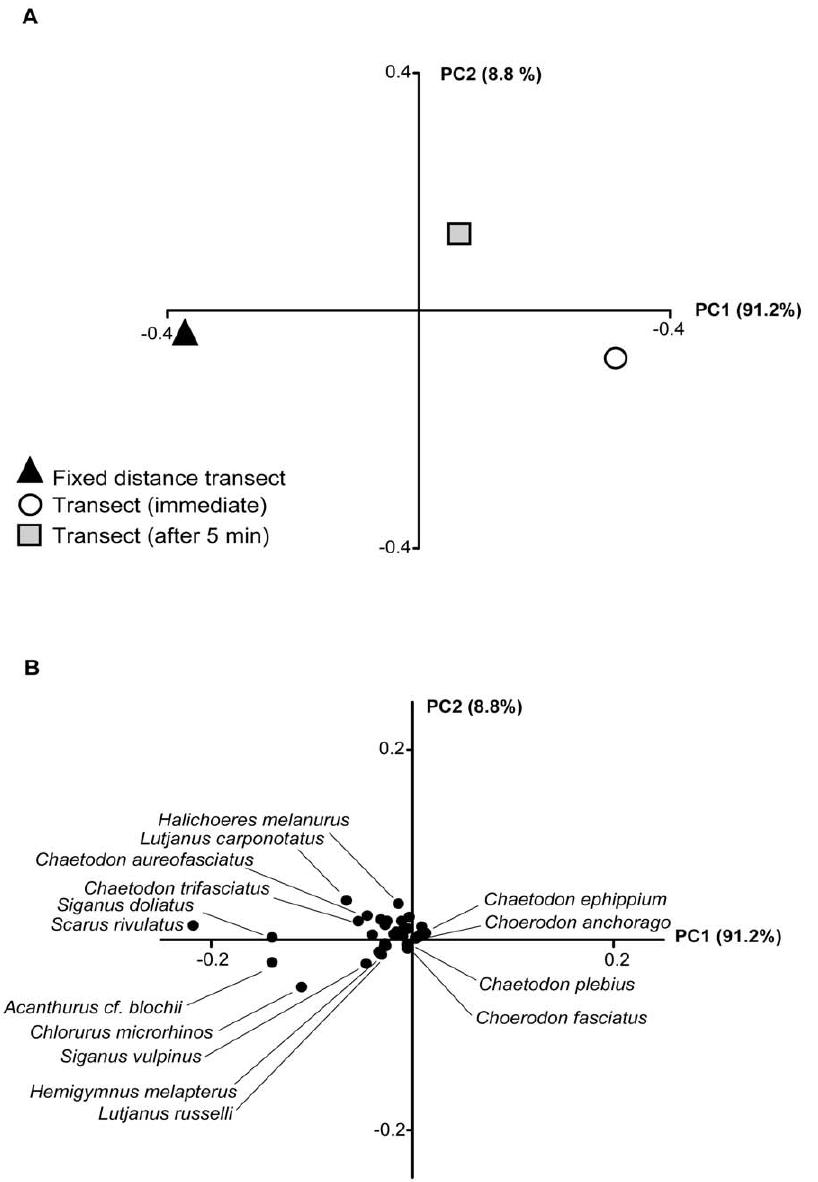
Figure 3. Principal components analysis showing species level differences in mean fish abundance between the three UVC techniques. ( A ) All 3 transects are clearly separated along PC1. ( B ) Vector plot showing the fish species driving patterns in relation to the three transects shown in ( A ).